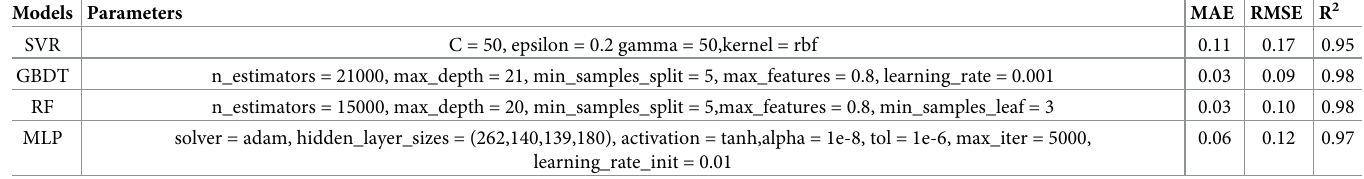
Table 3. Statistics of predicted bandgaps by SVR, GBDT, RF and MLP algorithms based on a 9-dimensional feature space. Models Parameters MAE RMSE R